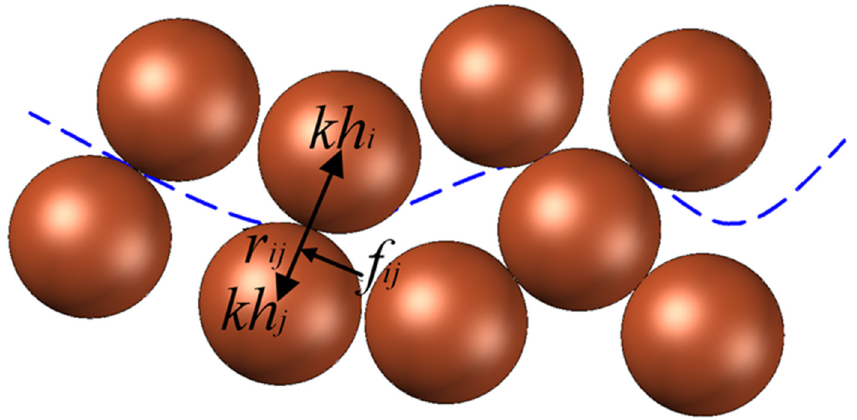
Figure 2. Contact between SPH particles (the blue line is the schematic diagram of the particle boundary).